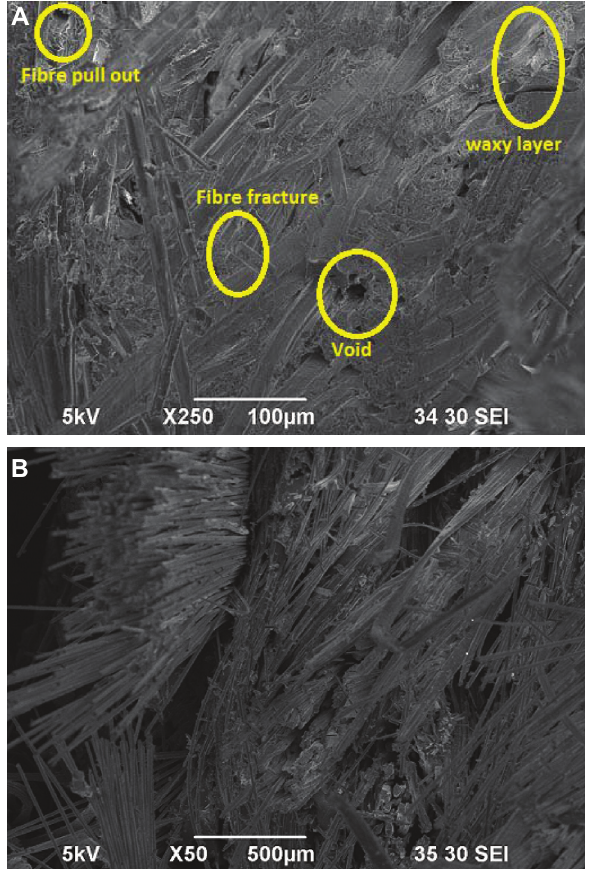
Figure 8 Fractography image of impact strength-tested specimen.